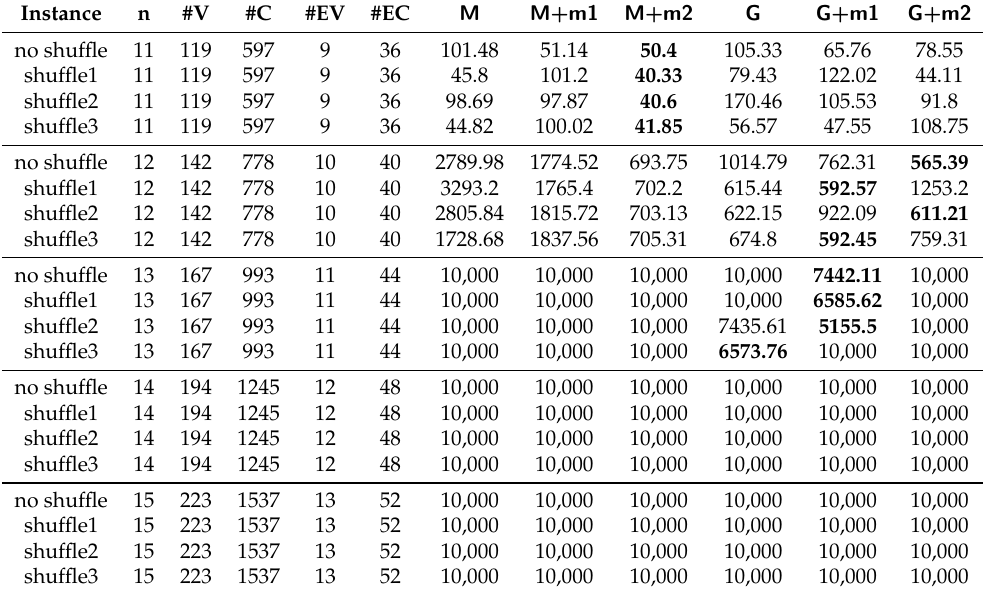
Table 3. Results of PHP instances with partial